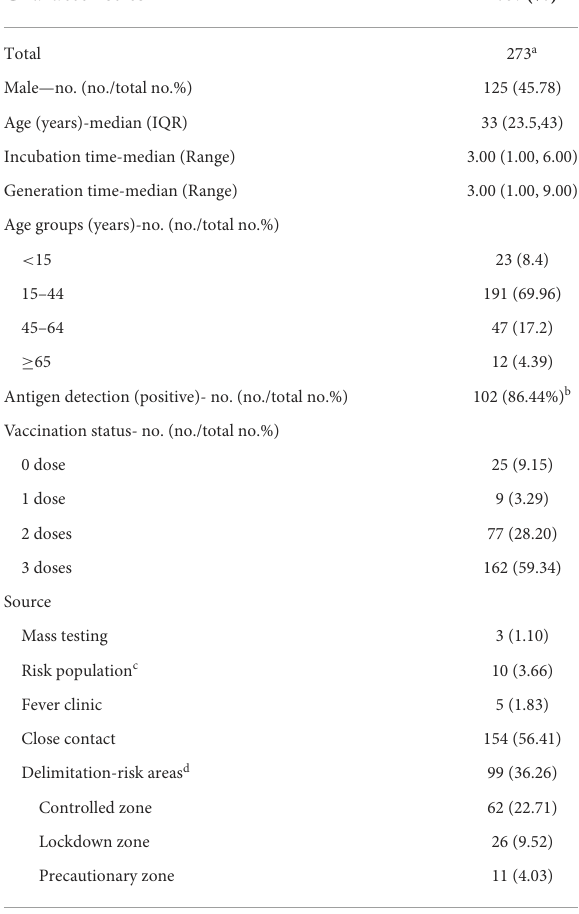
TABLE 2 Demographic characteristics of the subjects infected with the SARS-CoV-2 Omicron variant in Guangzhou, 2022.